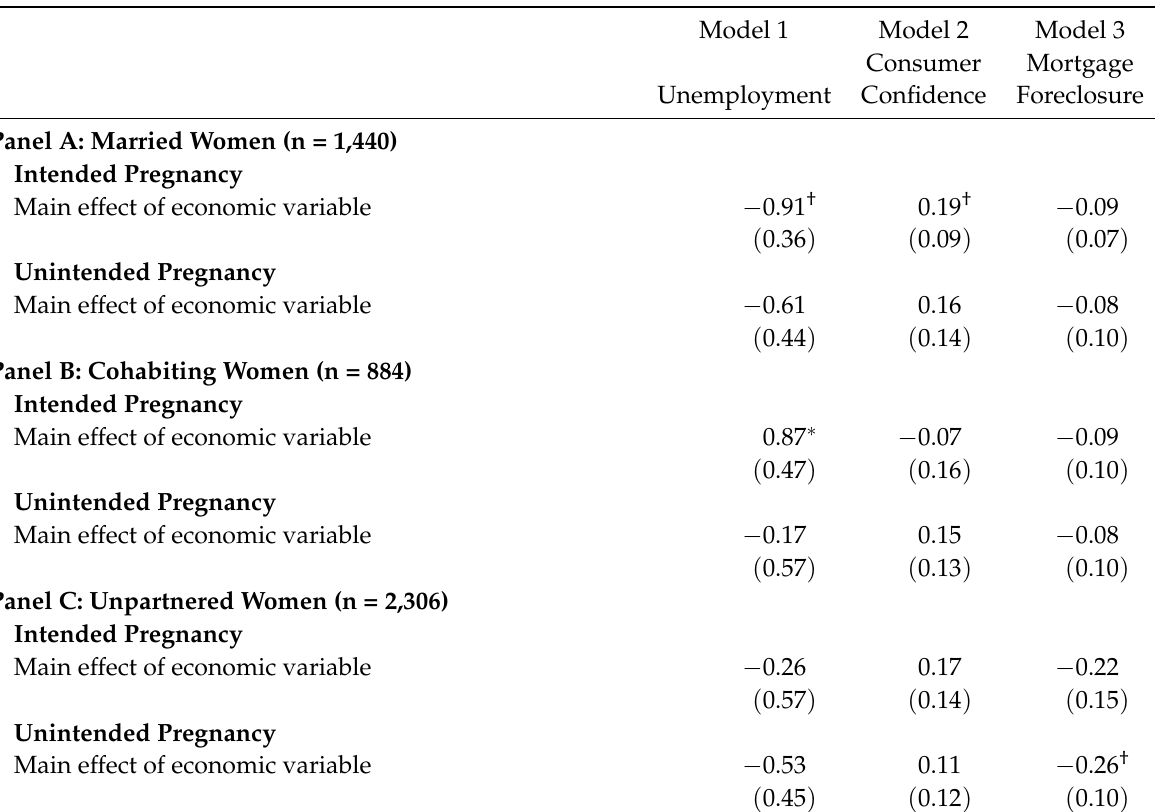
Table 3: Coefficients from mlogit models predicting intended and unintended pregnancy relative to no pregnancy by state-level economic conditions with covariates for partnership status. (Sample: all fertile adult women without a college degree. n =